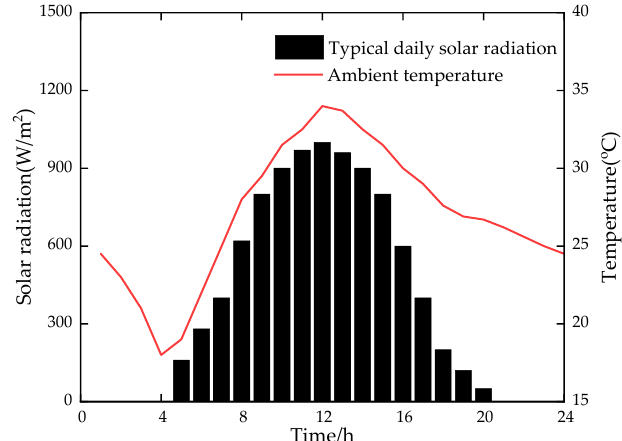
Figure 4. Solar radiation and ambient temperature. Table 1. Related parameters of the hydrogen production system.